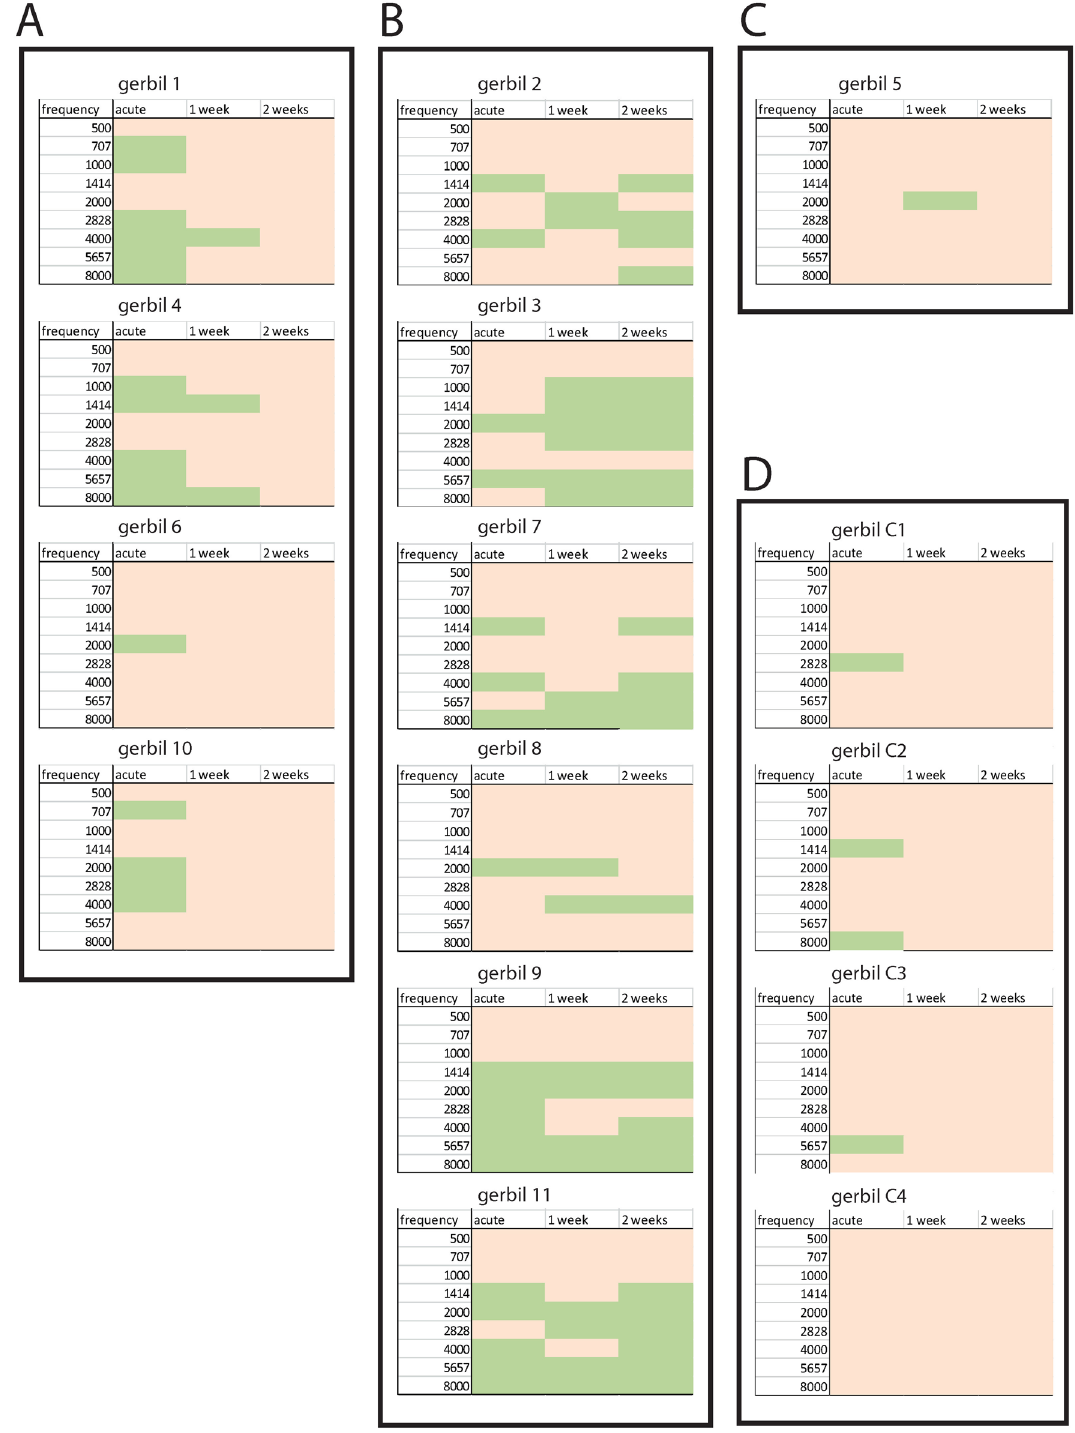
Figure 3. Temporal development of behavioral signs of tinnitus. ( A , B ) Immediately after notched noise exposure 10 of 11 tested animals showed behavioral signs of tinnitus (green fields). ( C ) Only one animal treated with notched noise did not develop tinnitus. Within 2 weeks after notched noise exposure tinnitus related behavioral signs vanished completely in four animals ( A ). In six animals, tinnitus was not removed but became chronic instead ( B ). ( D ) In the control group, three of four tested animals showed few behavioral signs of tinnitus only immediately after treatment with broadband noise. Green fields indicate behavioral signs of tinnitus, defined as significant changes of the effect size of the PPI change. Pink fields indicate non-significant changes. Note that, on a 5% level we cannot rule out that we detect false positive behavioral signs of tinnitus in a certain frequency range. In principle, also gerbil 6 could be assigned to group C. However, since in gerbil 6, we detect the behavioral signs of tinnitus immediately after instead of 1 week after treatment as it is the case in gerbil 5, it is therefore more likely that gerbil 6 is a true positive while gerbil 5 is a false